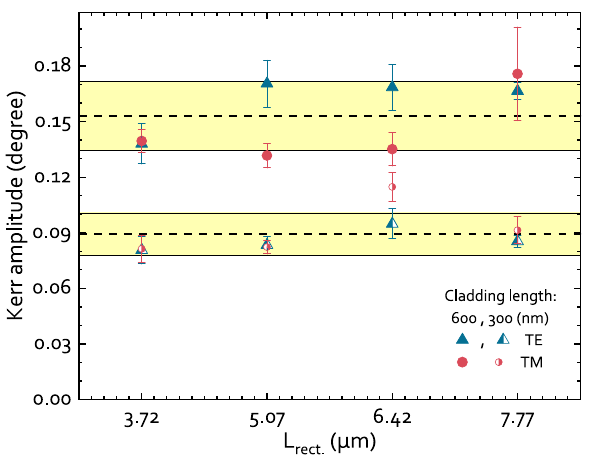
) determined from devices with Figure 7: Kerr amplitudes ( Φ TX varying propagation lengths in the rectangular waveguide section ). The results from devices with two different cladding lengths ( L rect. = 300 and 600 nm) are shown. Each data-point is the result of ( L clad. are used. The a fitting procedure where 4 devices with varying L tri error bars indicate the accuracy of the fits. The dashed horizontal lines show the average Kerr amplitude, while the widths of the highlighted regions indicate the standard deviation of the reported